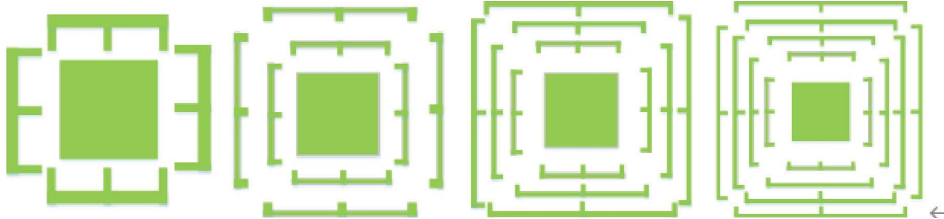
Figure 6: Evolution of the unit